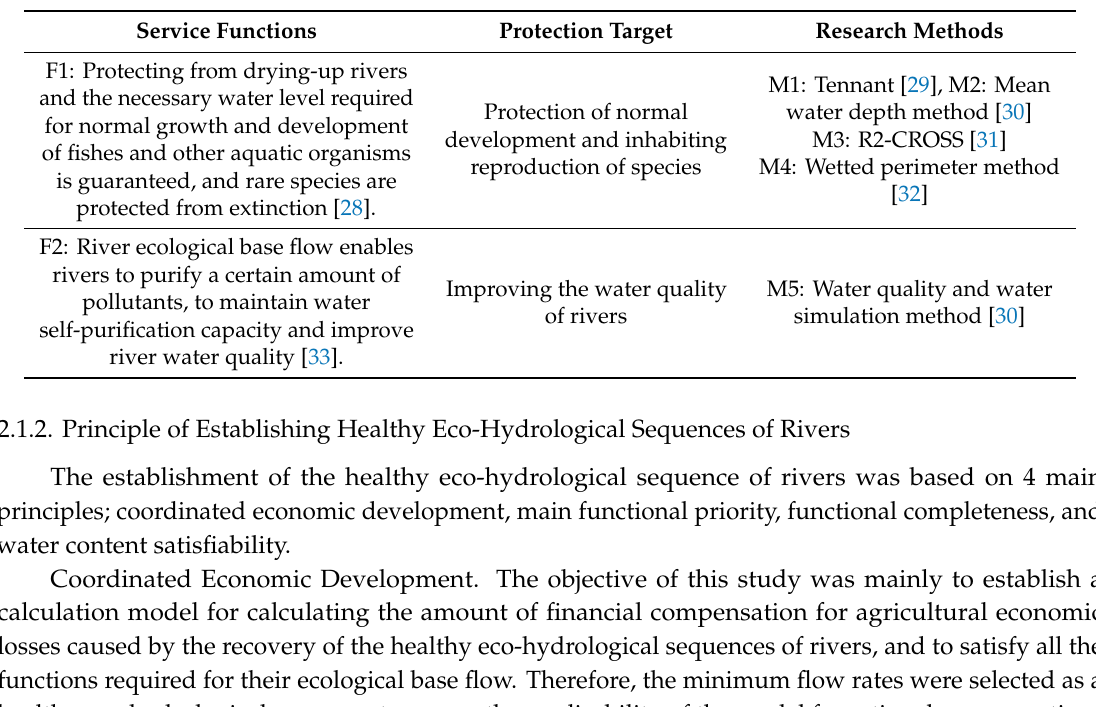
Table 1. Maintaining the basic healthy ecological functions of rivers and their calculation